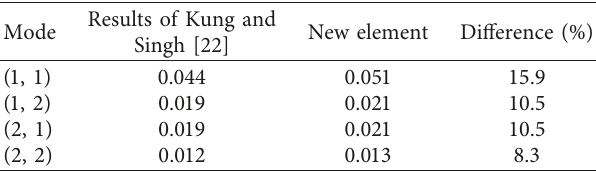
Table 3: Comparison of loss factor between the data in Kung and Singh [22] and new plate finite element.